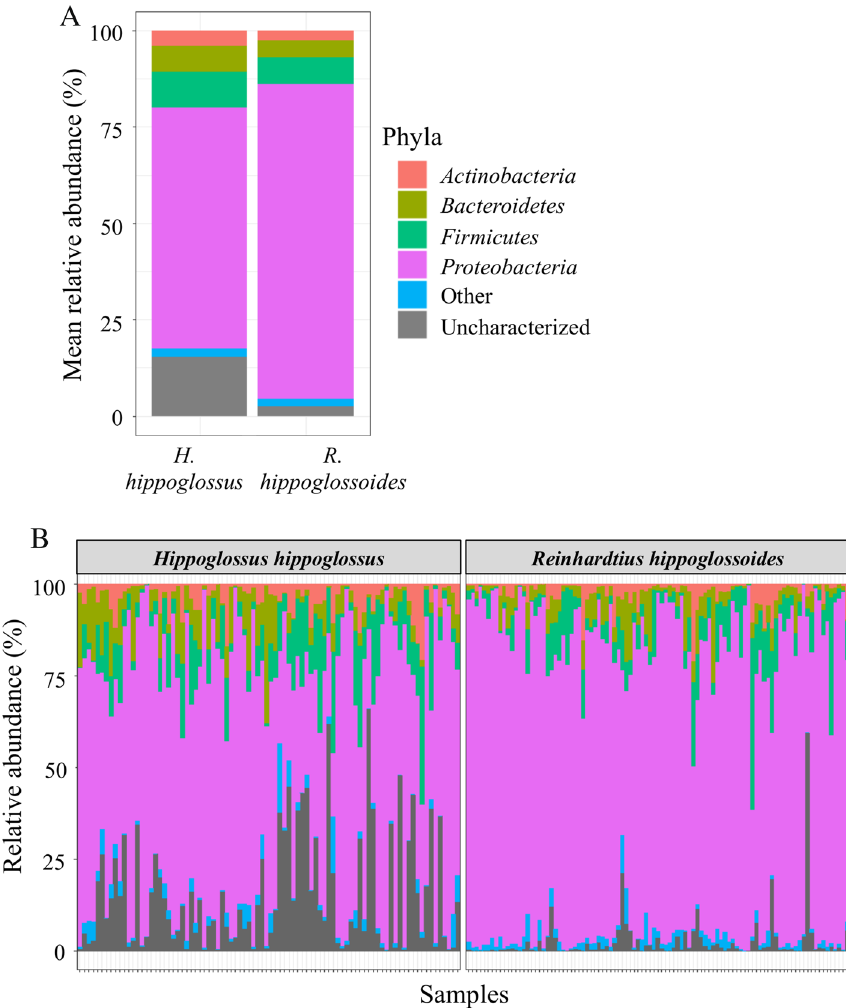
Figure 2. Microbiome structure at the phylum level. ( A ) Mean relative abundance (%) of the four main phyla present in the blood microbiome of Atlantic halibut ( H. hippoglossus ) and Greenland halibut ( R. hippoglossoides ). ( B ) Individual variation in the relative abundance (%) of the main phyla of Atlantic halibut (n = 86) and Greenland halibut (n =